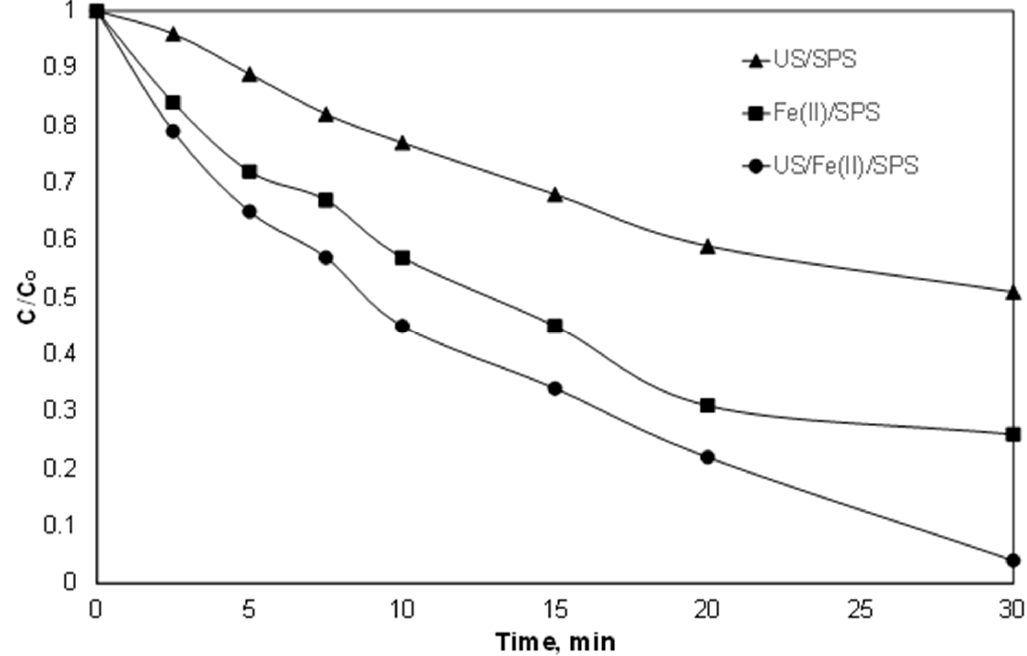
Figure 8. Normalized concentration of PIR degradation with Fe 2+ /SPS, US/SPS and Fe 2+ /US/SPS. [PIR] = 500 µ g/L, [Fe 2+ ] = 2 mg/L, [SPS] = 20 mg/L, ultrapure water and inherent pH. US: ultrasound.